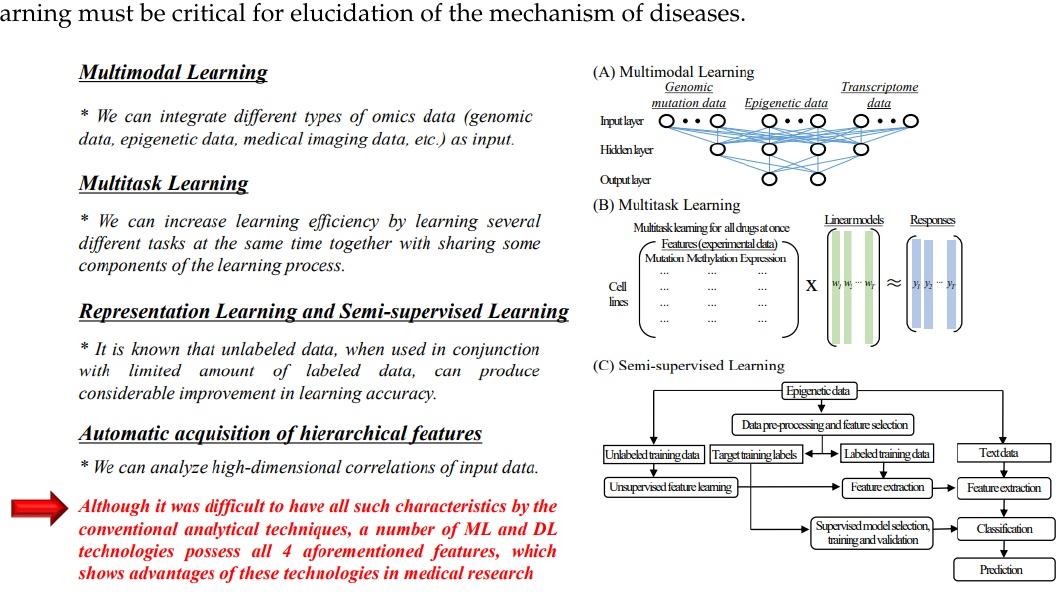
Figure 3. Advantages of machine learning and deep learning technologies in medical research. ( A ) An example of multimodal learning analysis using multiomics data including epigenetic data. ( B ) An example of multitask learning analysis using gene mutation data, DNA methylation data and gene expression data. This is a modified figure from reference [113]. ( C ) An example of semi-supervised learning using epigenetic data. This is a modified figure from reference [114].